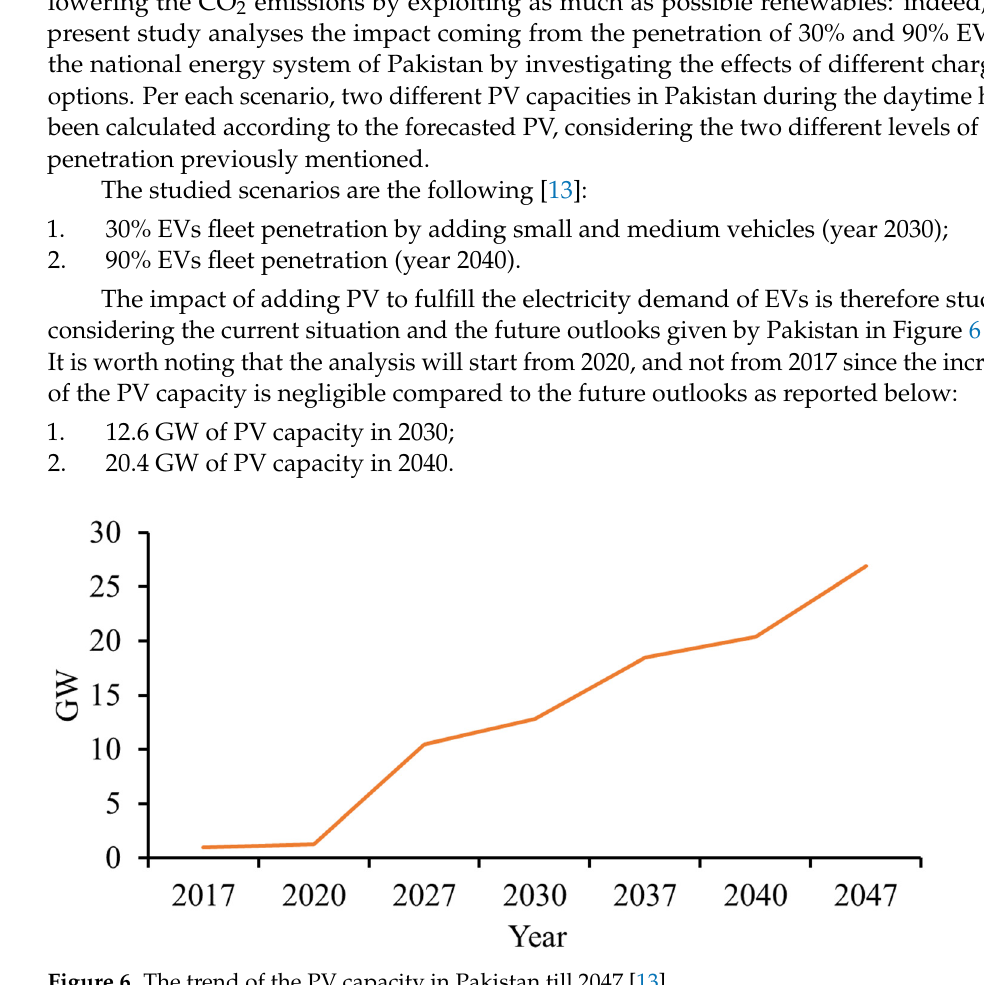
Figure 7. CO 2 emissions trend in Pakistan from 2002 till 2018. The mathematical correlation used to calculate the CO 2 emissions due to the use of FFVs is reported by Equation (1): 𝑐𝑜 (cid:2870)(cid:2868)%(cid:3006)(cid:3023) (cid:3404) (cid:3533) 𝐸 (cid:3036)(cid:3041) (cid:3036) (cid:3400) 𝑐𝑜 (cid:2870) , 𝑖